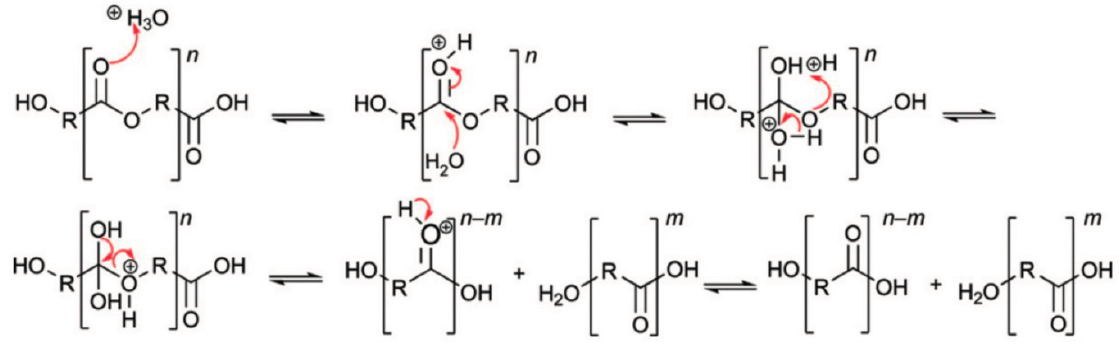
Figure 2. Acid-catalysed hydrolysis of polyesters, originally published in